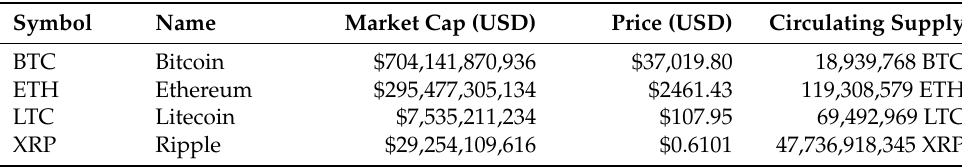
Table 1. Capitalization of the